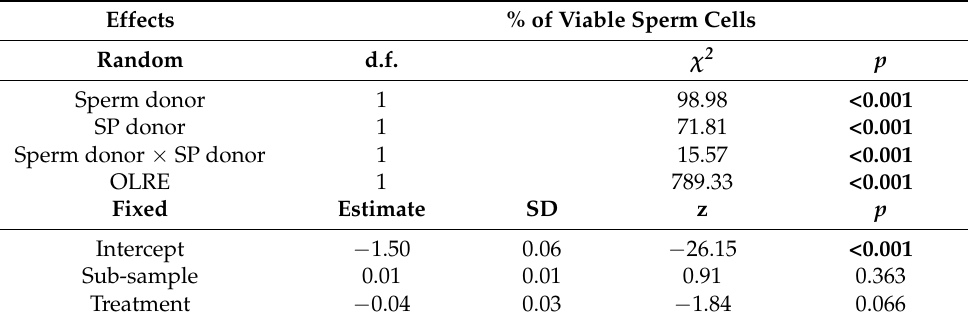
Table 3. Generalized mixed model (GLMM) statistics for the effect of sperm donor, SP donor, and their interaction (random effects) on sperm viability. Model also included fixed effects of sub-sample and treatment (own or foreign SP). OLRE = observation-level random